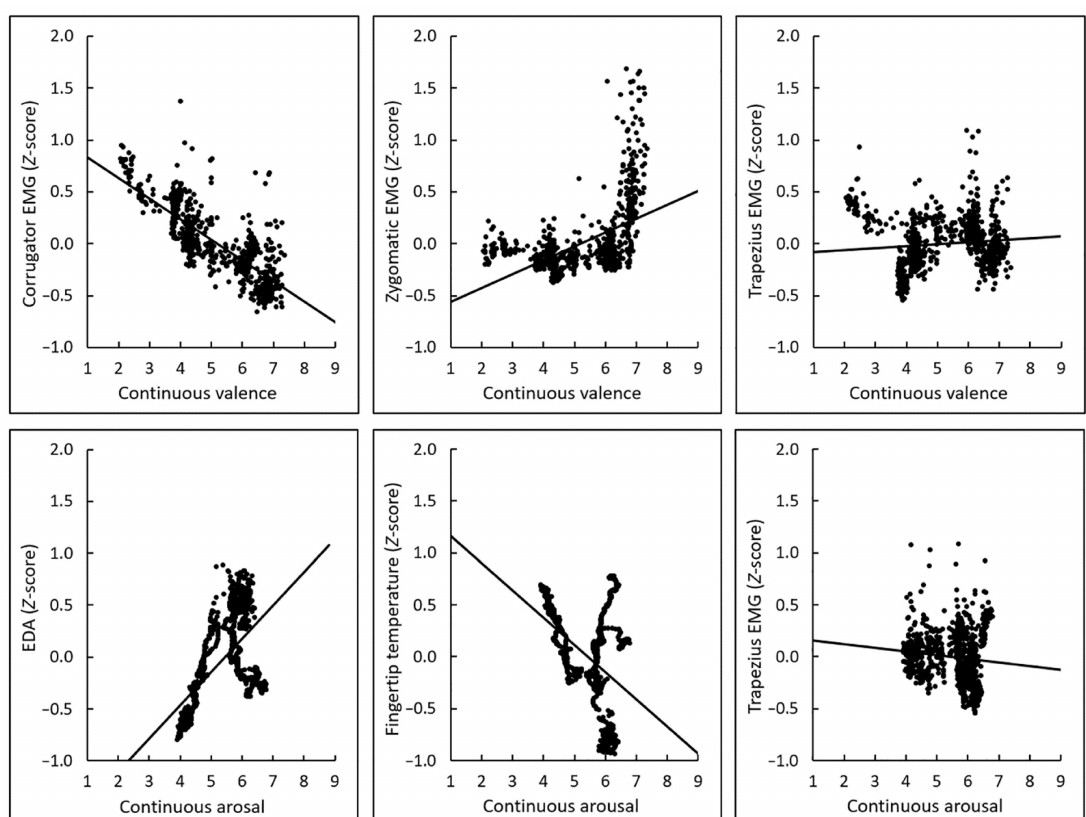
Figure 3. Group-mean scatterplots and regression lines of the expected subjective–physiological con- cordance over time. Associations were expected between the valence ratings and electromyography (EMG) activity recorded from the corrugator supercilii, zygomatic major, and trapezius muscles, and between the arousal ratings and electrodermal activity (EDA), fingertip temperature, and trapezius EMG. Physiological data were standardized within individuals.